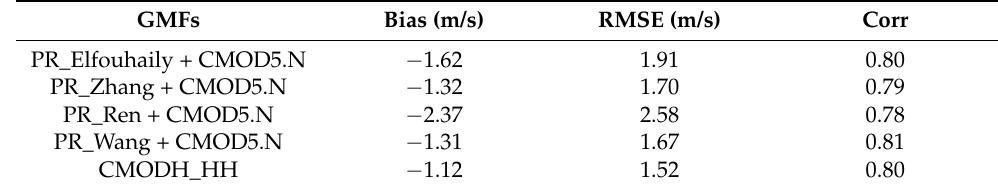
Table 5. Comparison of wind speed retrieval results of the GF3-02 HH polarization data based on each GMF model and HY-2B SCA wind data. GMFs Bias (m/s) RMSE